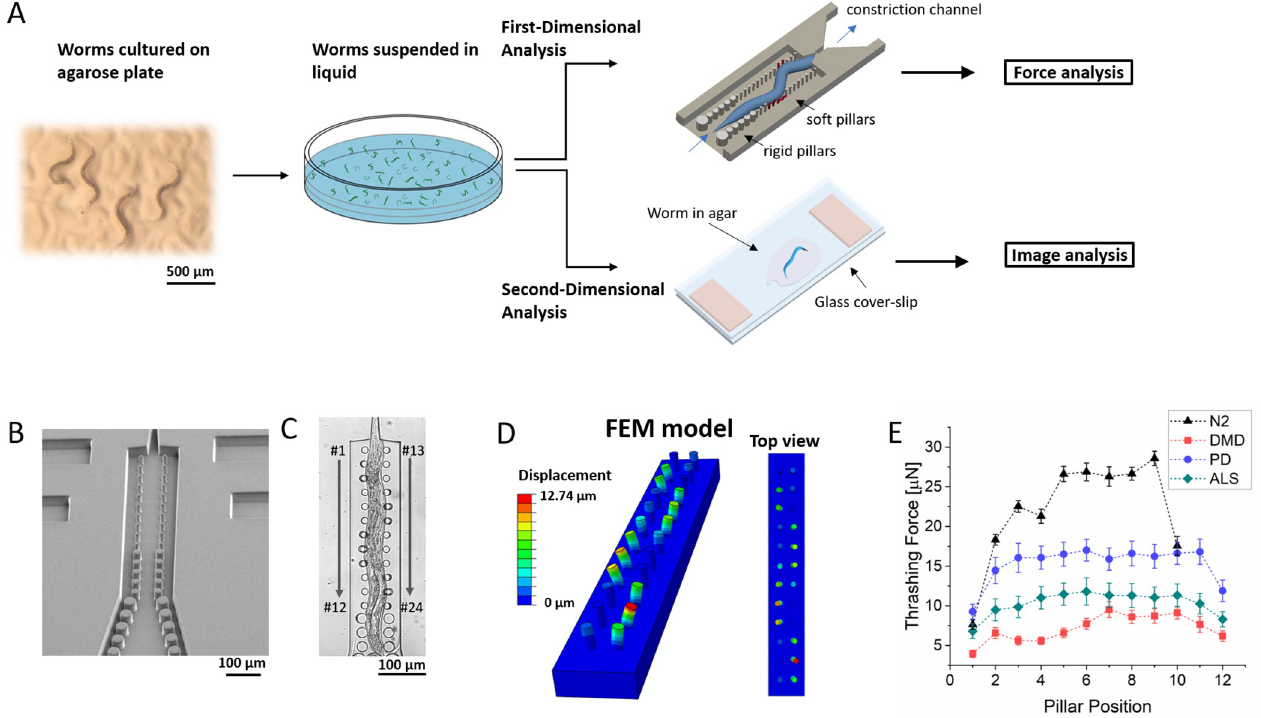
Fig 1. Evaluation of drug efficacy in C . elegans using two-dimensional analysis. (A) Protocol for two-dimensional analysis. The first-dimensional analysis evaluated the change in thrashing force exerted by the worm before and after drug treatment. The second-dimensional analysis used fluorescence imaging- based analysis to evaluate the effect of drug treatment on morphology of the body wall muscles and protein aggregation. (B) Scanning electron micrograph of the force assay chip showing elastomeric micropillars. (C) Optical image showing a partially immobilized young adult worm thrashing on micropillars. (D) Non-linear finite element model used to calculate the thrashing force from the displacements of micropillars. The deflection of micropillars in the FEM image matches that of the optical image in (C). (E) Line graph showing thrashing forces of wild type N2, DMD, ALS and PD model worms in young adult stage. The disease model worms showed a 68.7%, 55.4% and 35.7% decrease in thrashing force for DMD, ALS and PD strains, respectively, compared to the thrashing force of wild-type N2.